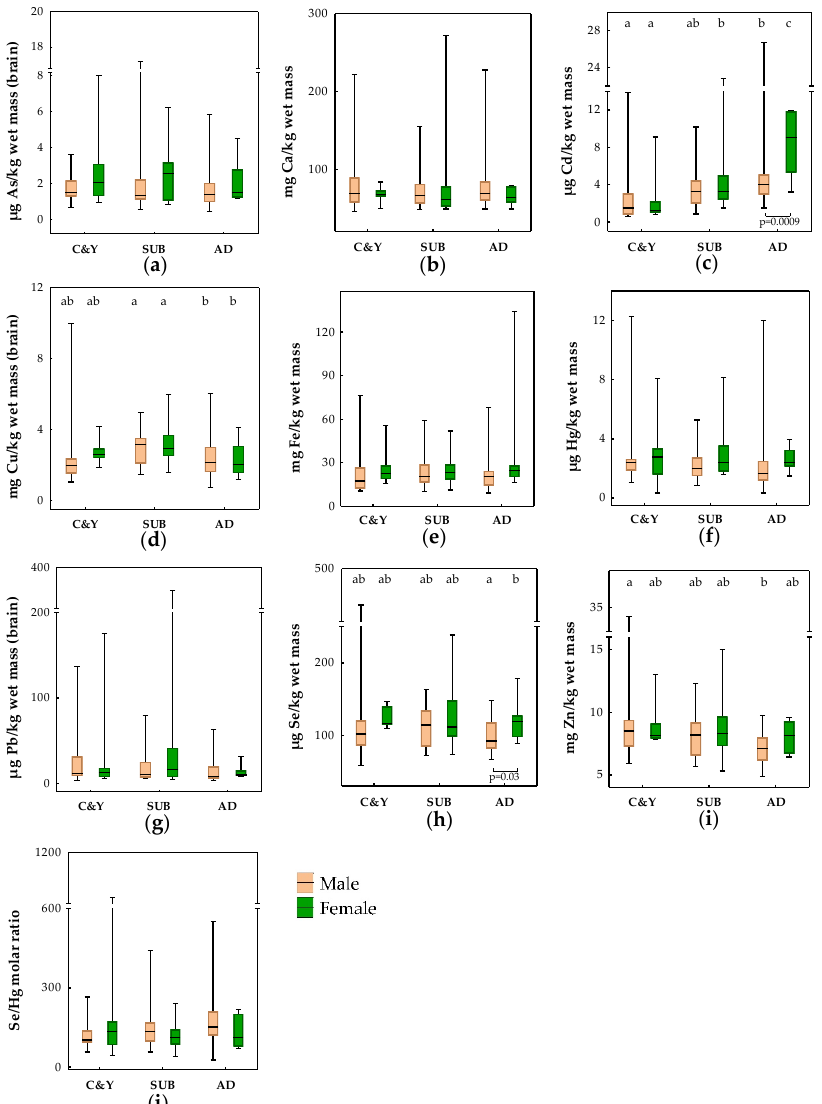
Figure 1. Age group and sex differences in the brain levels of ( a ) As; ( b ) Ca; ( c ) Cd; ( d ) Cu; ( e ) Fe; ( f ) Hg; ( g ) Pb; ( h ) Se; ( i ) Zn; and ( j ) Se/Hg molar ratios in brown bears from Croatia. Boxes denote interquartile range (IQR), the line in the box is the median, and whiskers denote minimum and maximum values. Significant differences between age groups within the same sex are marked with different letters above the boxes (a,b,c), while for sex differences within one age group, the level of significance is additionally noted below the boxes. C&Y — cubs and yearlings; SUB — subadults; AD — adults.